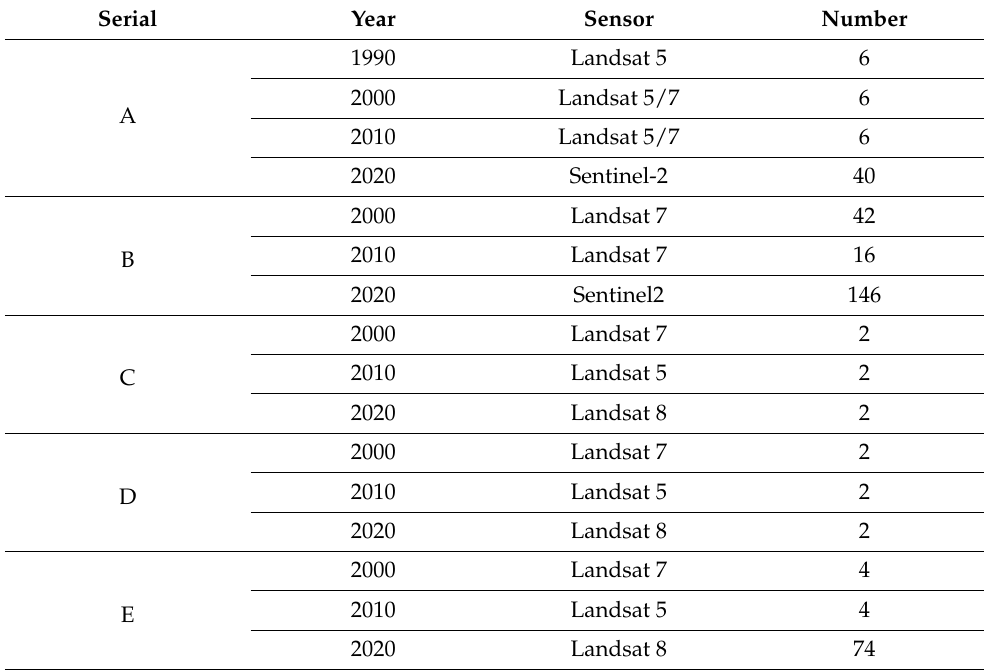
Table 2. The data source information of the remote sensing images used in five sites.